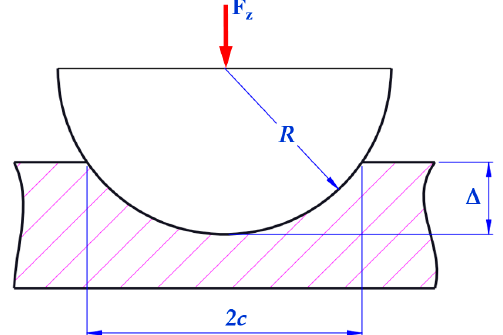
Figure 17. Unevenness-to-tread interaction scheme. The hemisphere-shaped unevenness with radius r pressed against the tread located